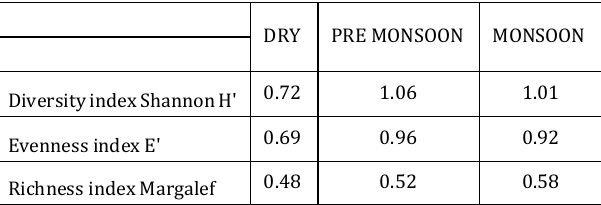
Table 7: Diversity indices at Station 4 during all